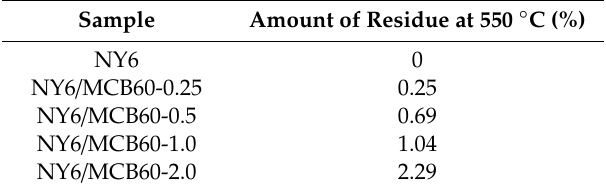
Table 5. Amount of residues at 550 ◦ C of the Nylon 6 and NY6 / MCB60